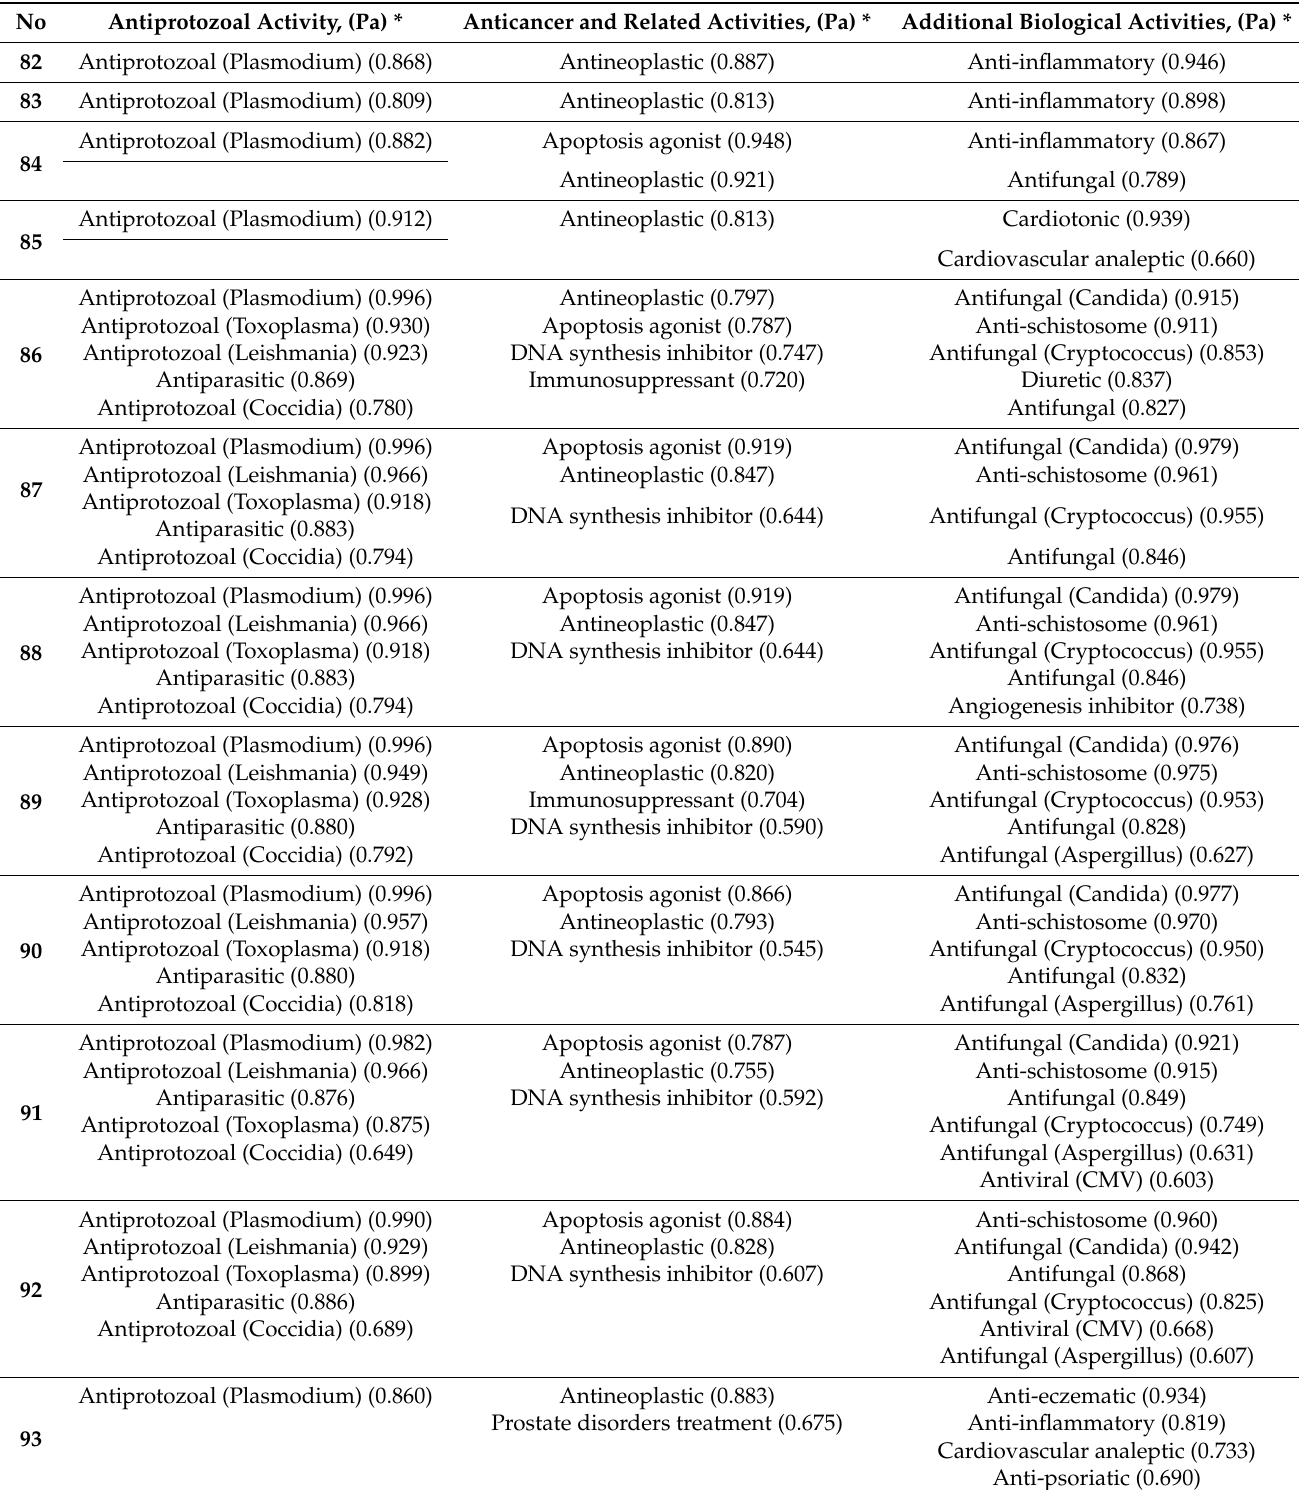
Table 6. Biological activity of the natural polycyclic peroxides derived from